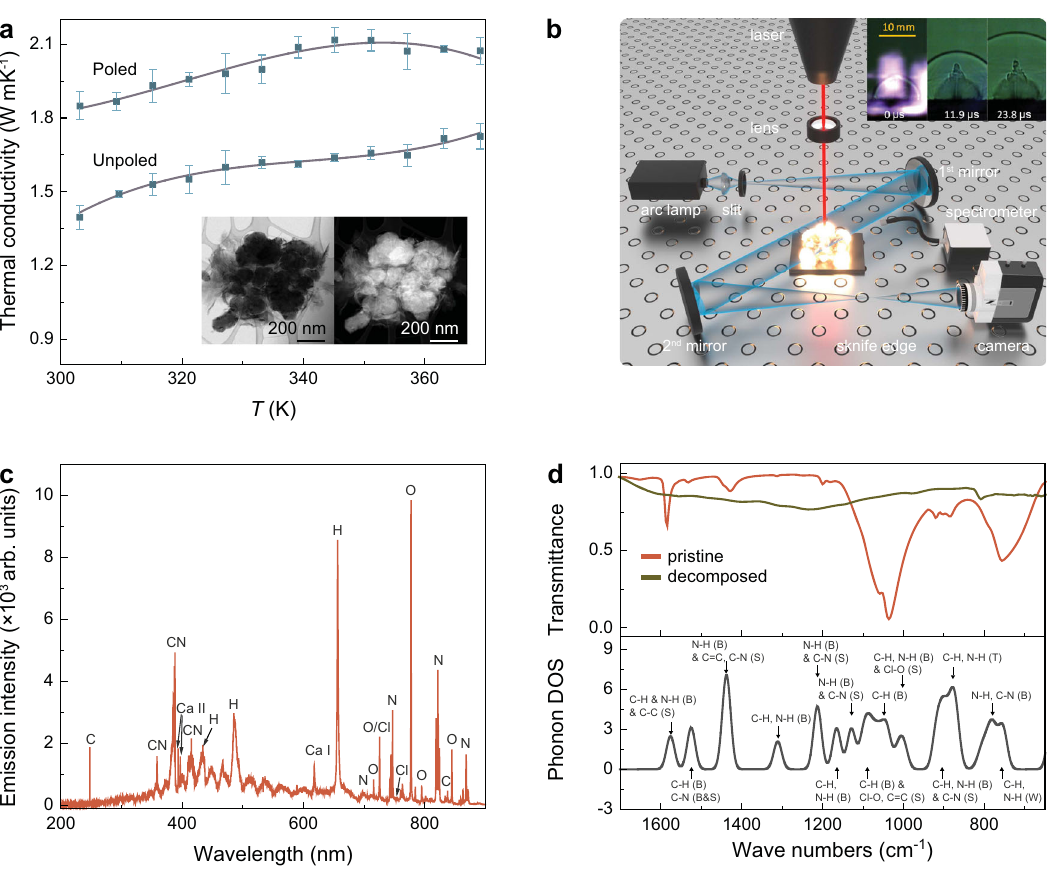
Fig. 3 Thermal and energetic performance of EIP. a Temperature dependence of thermal conductivity for poled and unpoled EIP. Inset show the HRTEM for unpoled EIP. b Schematic fi gure for laser-induced shock velocity images obtained from high-speed video. Arc lamp generates light which is focused through a slit onto the fi rst mirror. The collimated light between the fi rst and second mirror detects the change in the refractive index of air above the sample surface. A knife edge is applied to reduce approximately half the light rays. A spectrometer is used to simultaneously measure the plasma emission spectrum. Inset shows the selected snapshots from the high-speed video for laser-shocked EIP. c Plasma emission spectrum for EIP during decomposition. The only impurity is Ca, and the only molecular recombination species observed during the fi rst 10 μ s is CN. d FTIR spectra for EIP before and after decomposition. Calculated phonon density of states (DOS) for EIP. bending (B); stretching (S); twisting (T); wagging (W). The phonon dispersion is shown in Supplementary Fig.